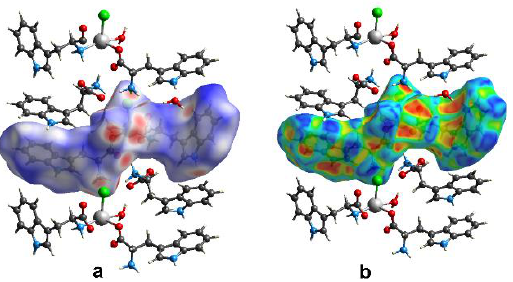
Figure 7. ( a ) Hirshfeld surfaces (HSs) generated for a mer unit of the polymeric chain viewed along the a axis. Over the HS d norm , ( b ) shape index properties are mapped; d norm is visualized over a fixed color scale of −0.694 (red), 0.430 (white) to 1.332 (blue).